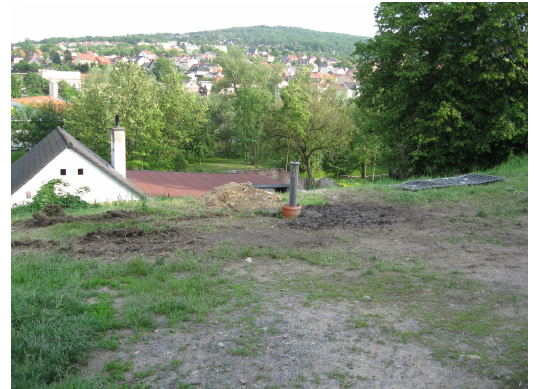
Figure 2. Temporary water pressure resistant steel casing of a borehole during realisation (located in an orange KG-System PVC sewage pipe backfilled in the manually dug trench).